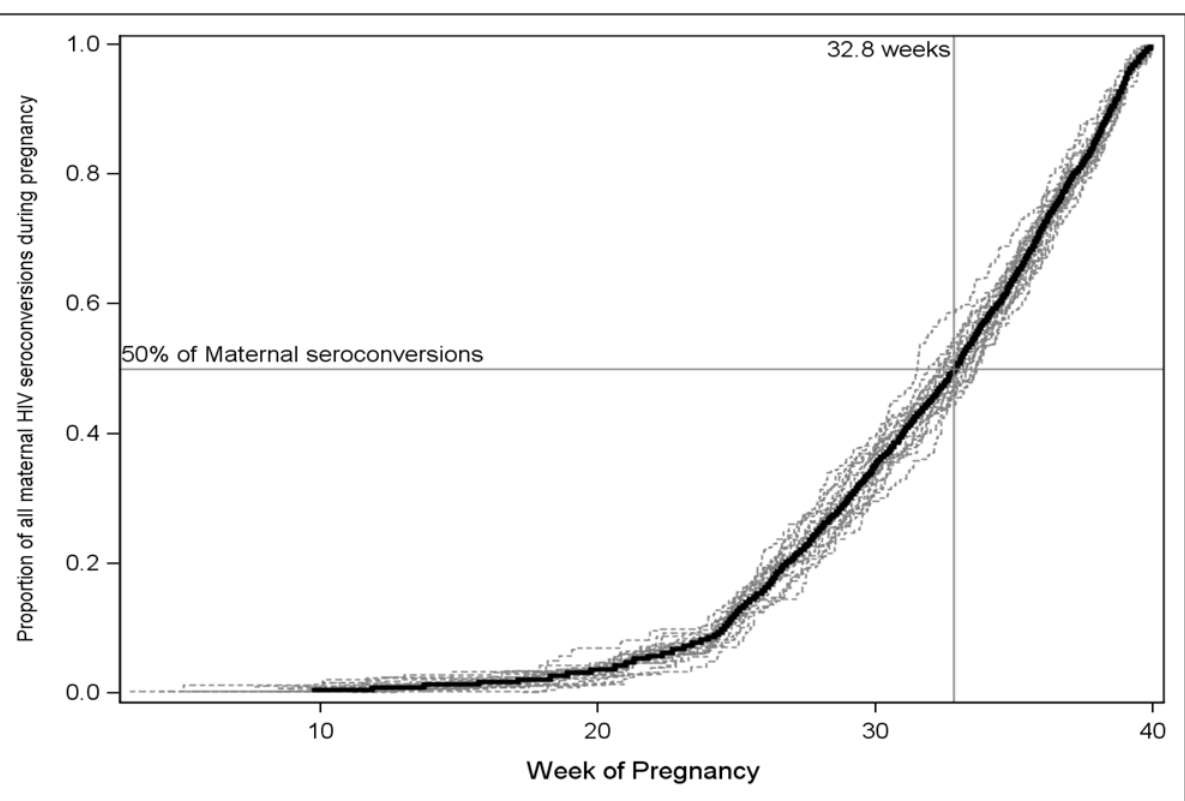
Fig 3. Estimated time of seroconversion for mothers with a negative HIV test result during PMTCT but became infected during their current pregnancy, South Africa, 2011 – 2012. This figure shows the results of a Kaplan-Meier (KM) time to event analysis of the time of seroconversion for 20 imputations of the weighted sample of 25,061 mothers represented by 211 sampled mothers who tested negative for HIV during this pregnancy and then became infected before they delivered their baby. Dashed lines represent the individual KM estimates for each of 20 imputations of the time of seroconversion, and the dark black line is the mean of these imputations. Median time of seroconversion was estimated to be 32.8 weeks of gestation, ranging from 31.5 to 33.6 across the imputations.